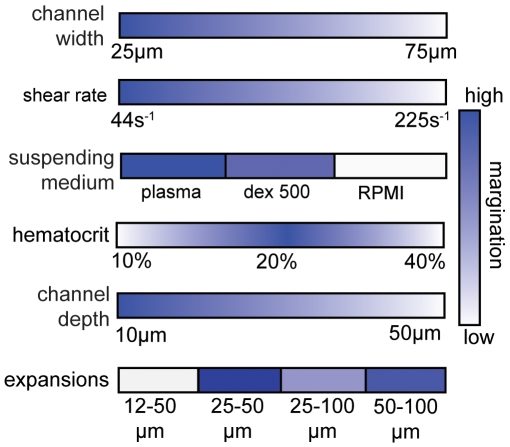
Summary of margination trends in microchannels.Margination depends on channel width (w), shear rate (γw), RBC aggregation induced by suspending medium, hematocrit (Ho), channel depth (d) and sudden expansion geometries. Darker color indicates more margination.